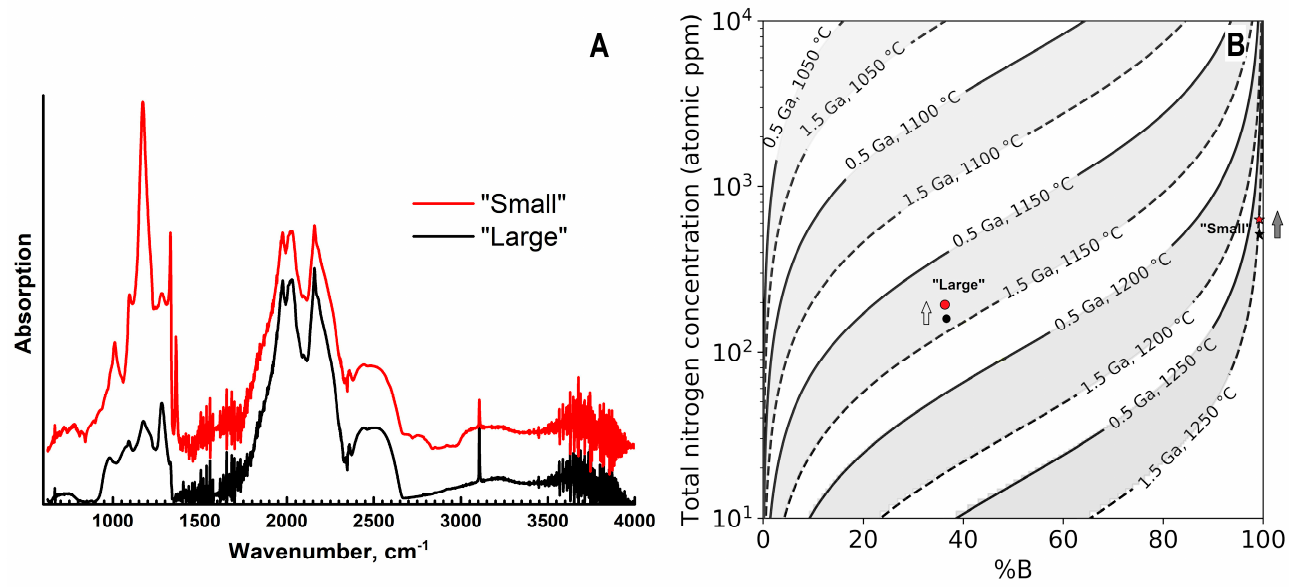
Figure 9. Infra-red spectra of two samples ( A ) and time-temperature history inferred from the nitrogen aggregation state ( B ). In A, the curves are displaced vertically for clarity. In B, arrows indicate the direction from the sample center to the edge.